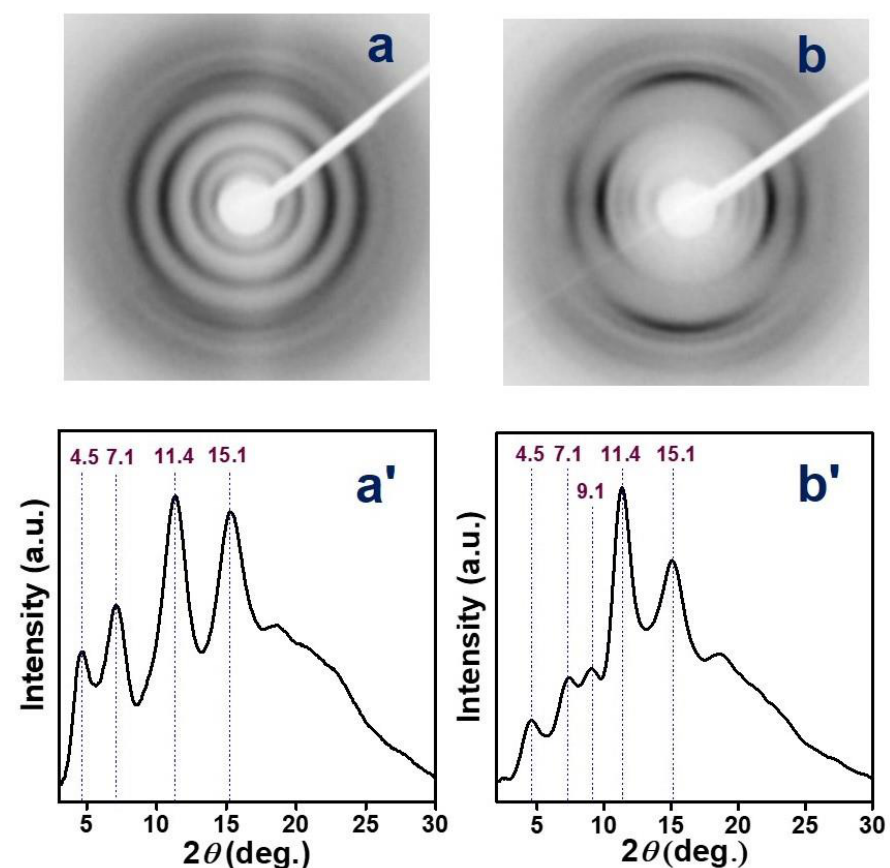
Figure 3. Two-dimensional-wide-angle X-ray diffraction (WAXD) EDGE patterns ( a , b ) and corresponding equatorial intensity profiles ( a’ , b’ ) of PPO/aPS (70/30; wt/wt) blend films as cast from toluene solutions: ( a , a’ ) unstretched; ( b , b’ ) stretched at 175 °C up to a draw ratio of 3. The 2D-WAXD EDGE pattern of the PPO/aPS (70/30; wt/wt) blend film, as cast from toluene solution, after partial toluene desorption at room temperature (toluene content ≈ 6wt.%) is